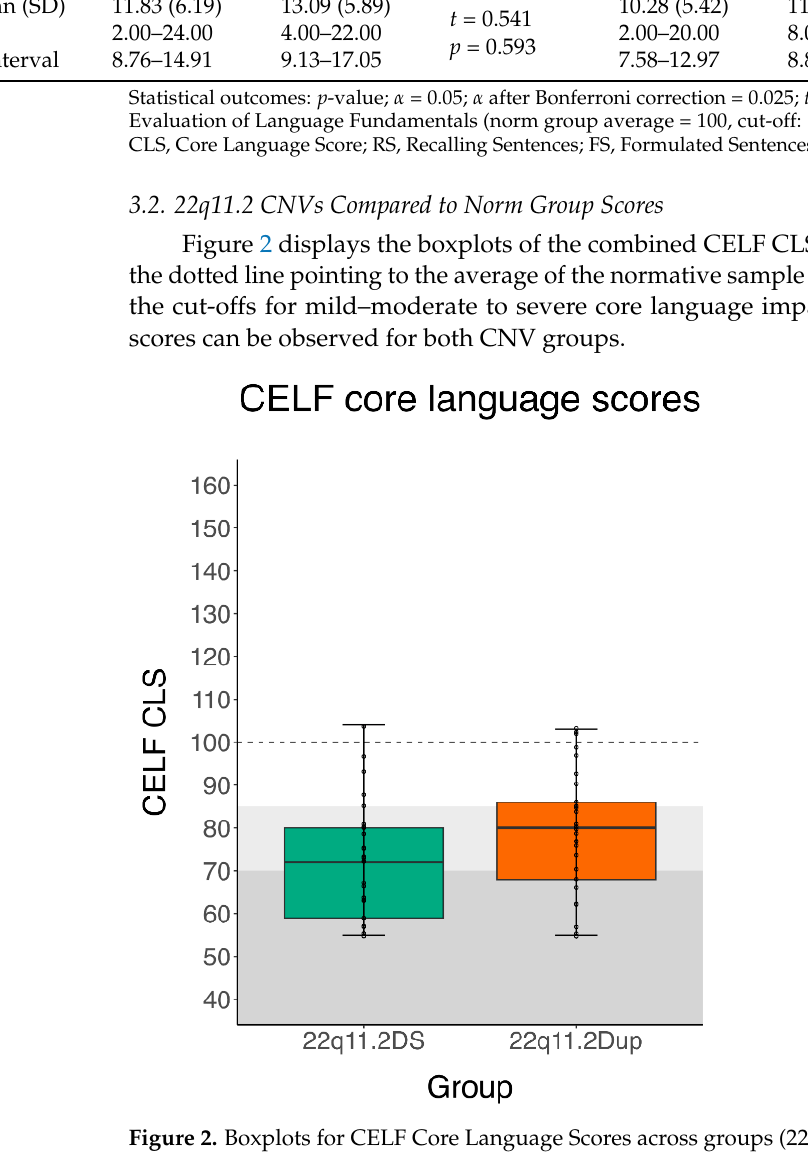
Table 2. Mean composite results on CELF across CNV groups and cohort sites.